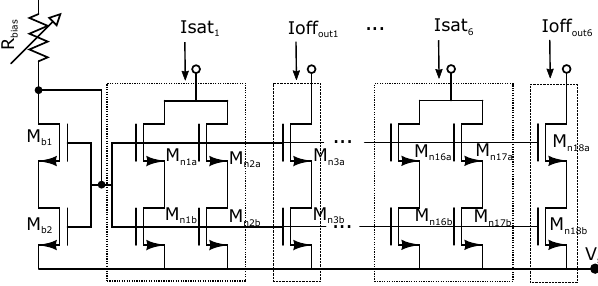
Figure 11. Proposed circuit to tune Isat and Iof f out in Figure 6. Table 5. Sizes of the circuit in Figure 10.